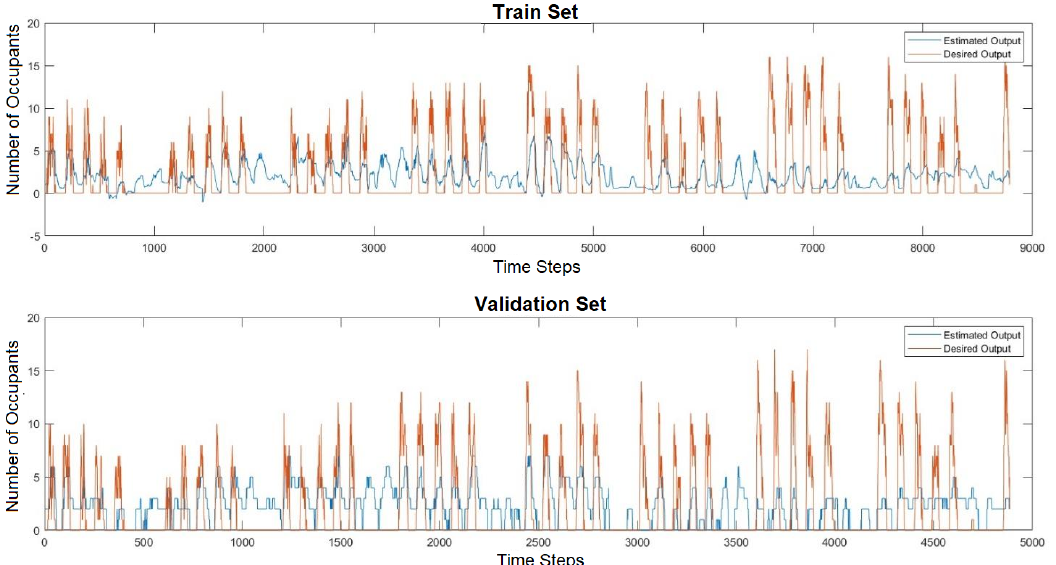
Figure 11. DE-OSELM occupancy prediction results, when the variables’ data set consists of outdoor parameters: T out , RH out , G out.